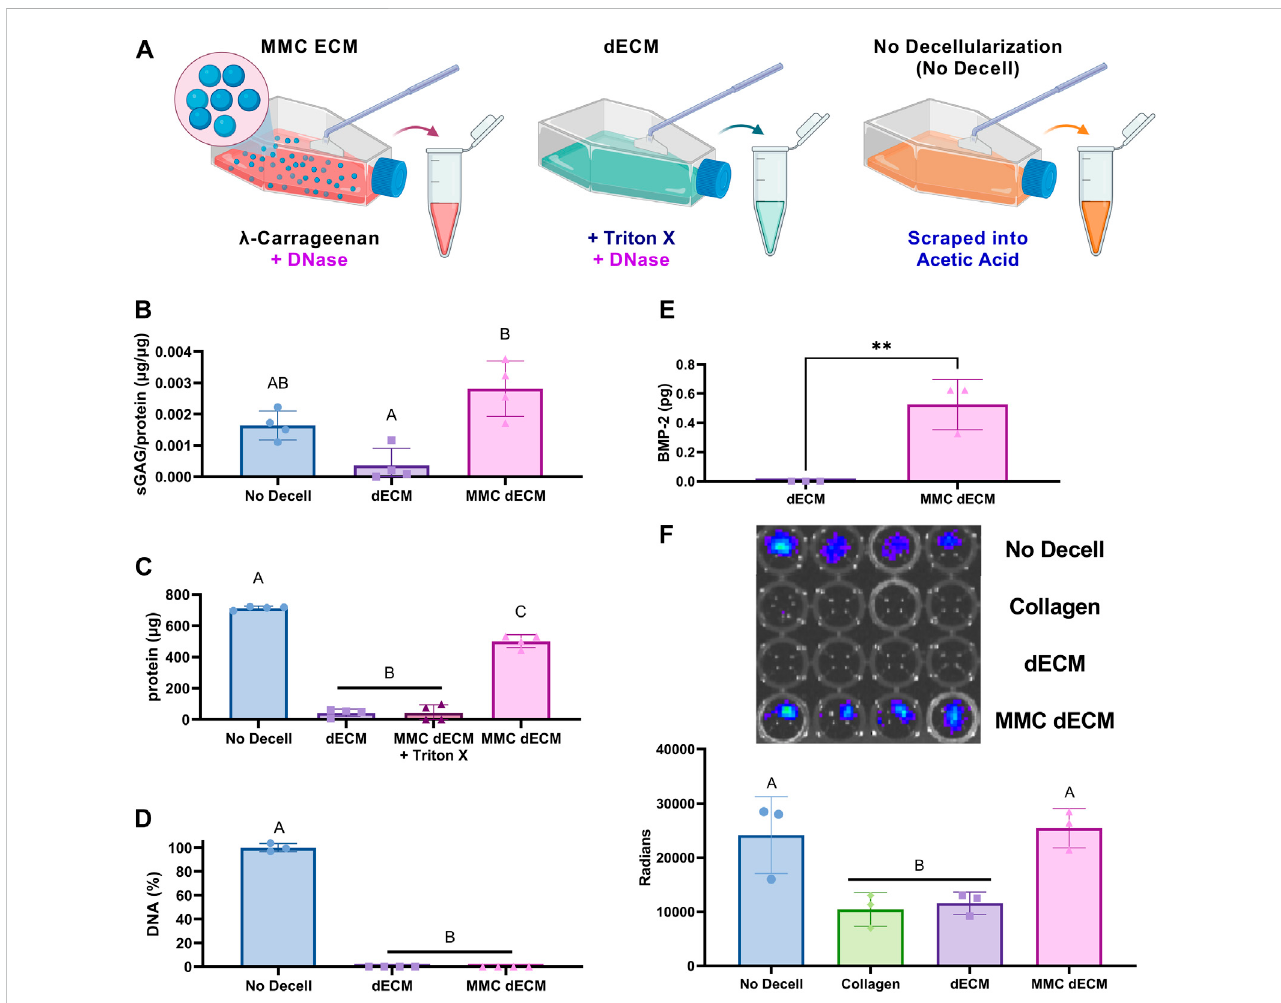
FIGURE 2 ECM yield and sulfated glycosaminoglycan content are in fl uenced by addition of λ -carrageenan and decellularization method. (A) Schematic depicting cultureanddecellularizationmethodsforECMproduction. (B) Quanti fi cationofsGAGcontentwithinECMsfollowingdimethylmethyleneblue(DMMB)assay. (C) Total protein content in ECMs. (D) Residual DNA content within ECMs. (E) Endogenous BMP-2 within the ECMs was detected directly via ELISA and indirectly with (F) luminescence of BRITER cells (top) and quanti fi cation (bottom). Data are mean ± SD ( n = 3 – 4). Groups with different letters are signi fi cantly different determined by one-way ANOVA or Student ’ s t -test as appropriate, ** p <